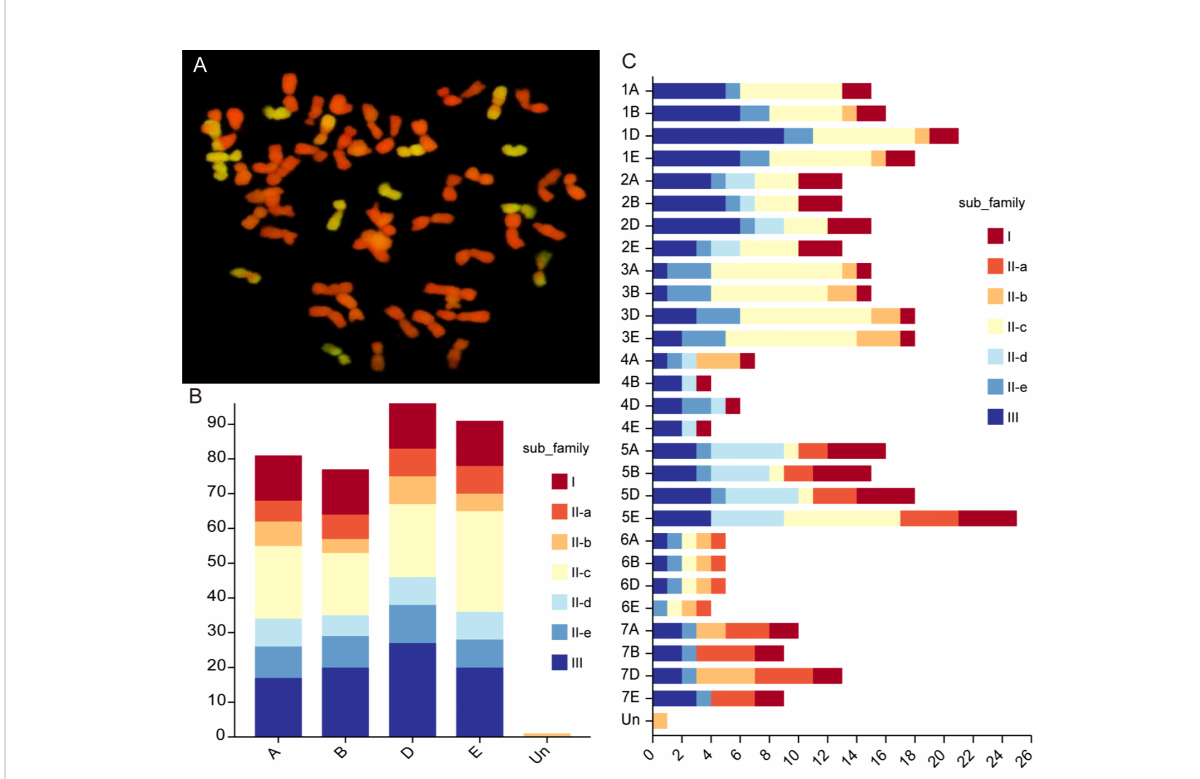
FIGURE 1 Chromosome con fi guration and distribution of WRKY genes in Tritipyrum. (A) Chromosome con fi guration of Tritipyrum ‘ Y1805 ’ ; (B) Subgenomes distribution of WRKY genes in Tritipyrum ; (C) Chromosomal distribution of WRKY genes in Tritipyrum